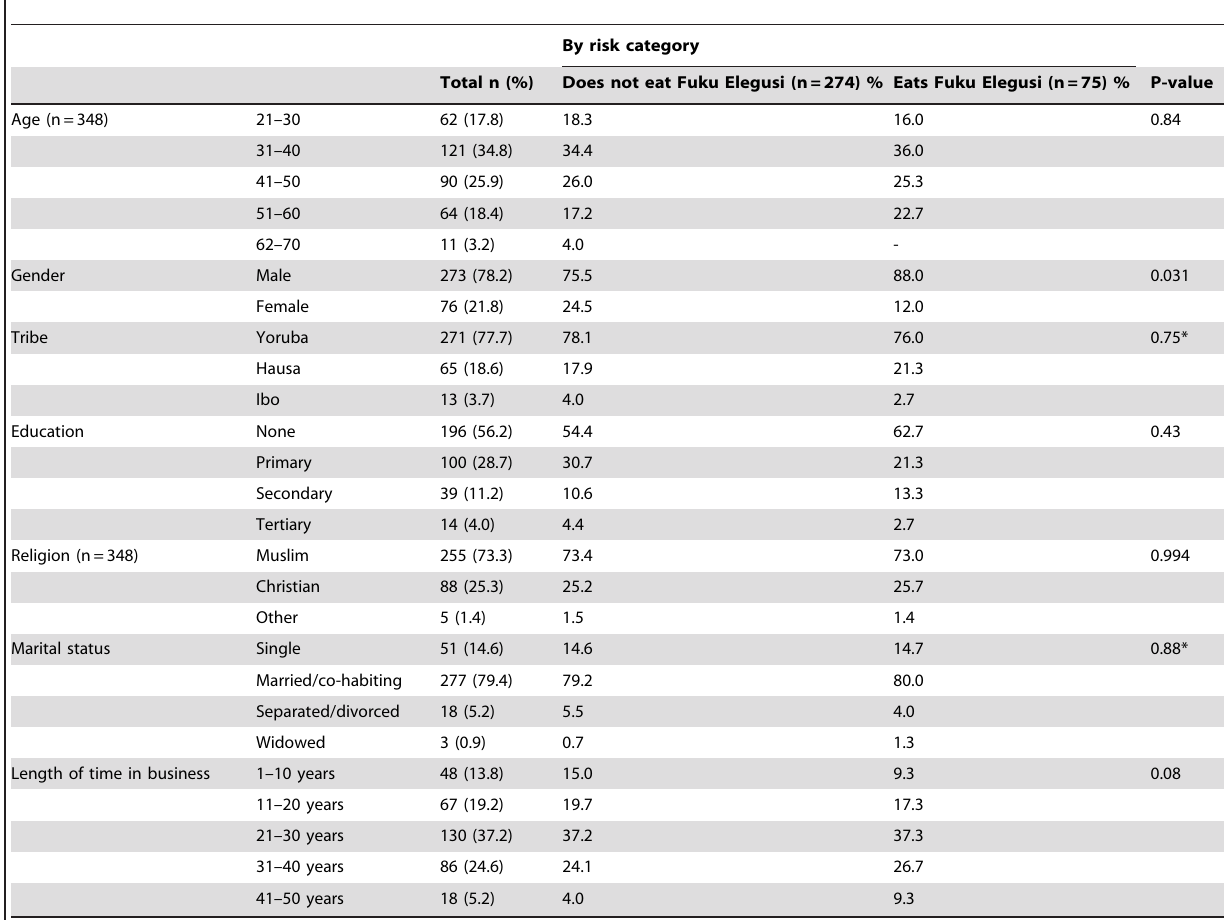
Table 2. Demographics, total and by whether they eat Fuku Elegusi (n= 349 unless otherwise stated).